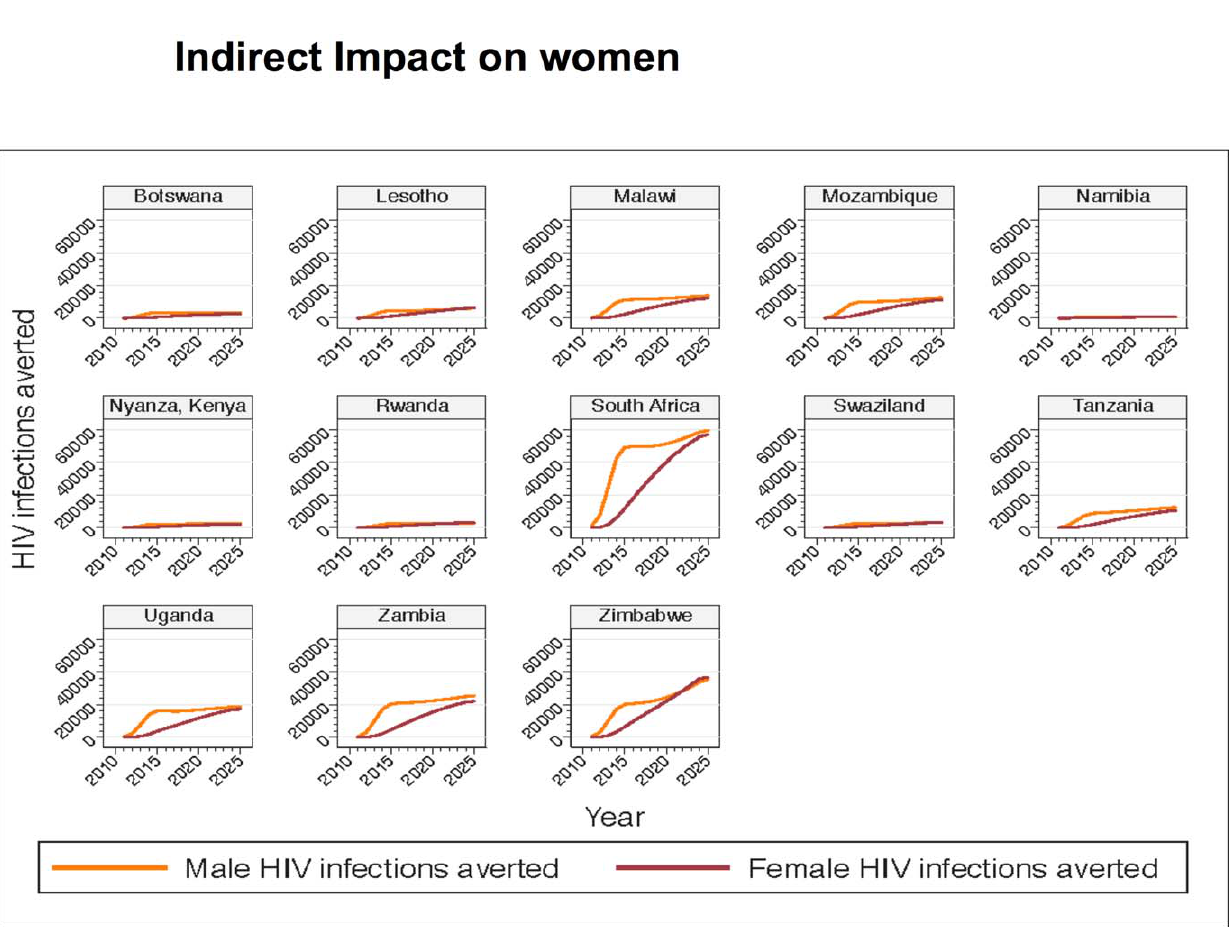
Figure 2. HIV infections averted in base case, by male and female, by country, 2011–2025. Figure 2 provides data for males and females for 2011–2025 for the base case scenario in which 80% coverage of VMMC is reached in 2015 and maintained thereafter, and there is no post- circumcision risk behavior change.